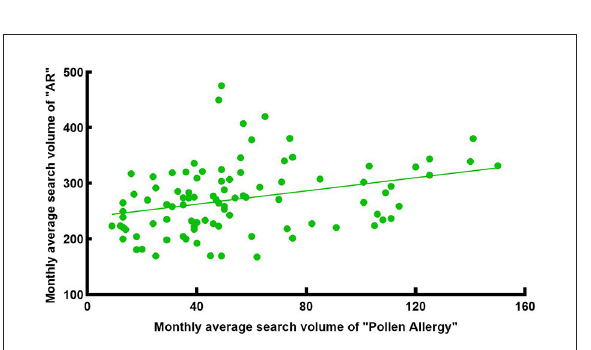
FIGURE7 Correlation between the search volume of “AR” and “Pollen Allergy” in Wuhan from 2014 to 2021.